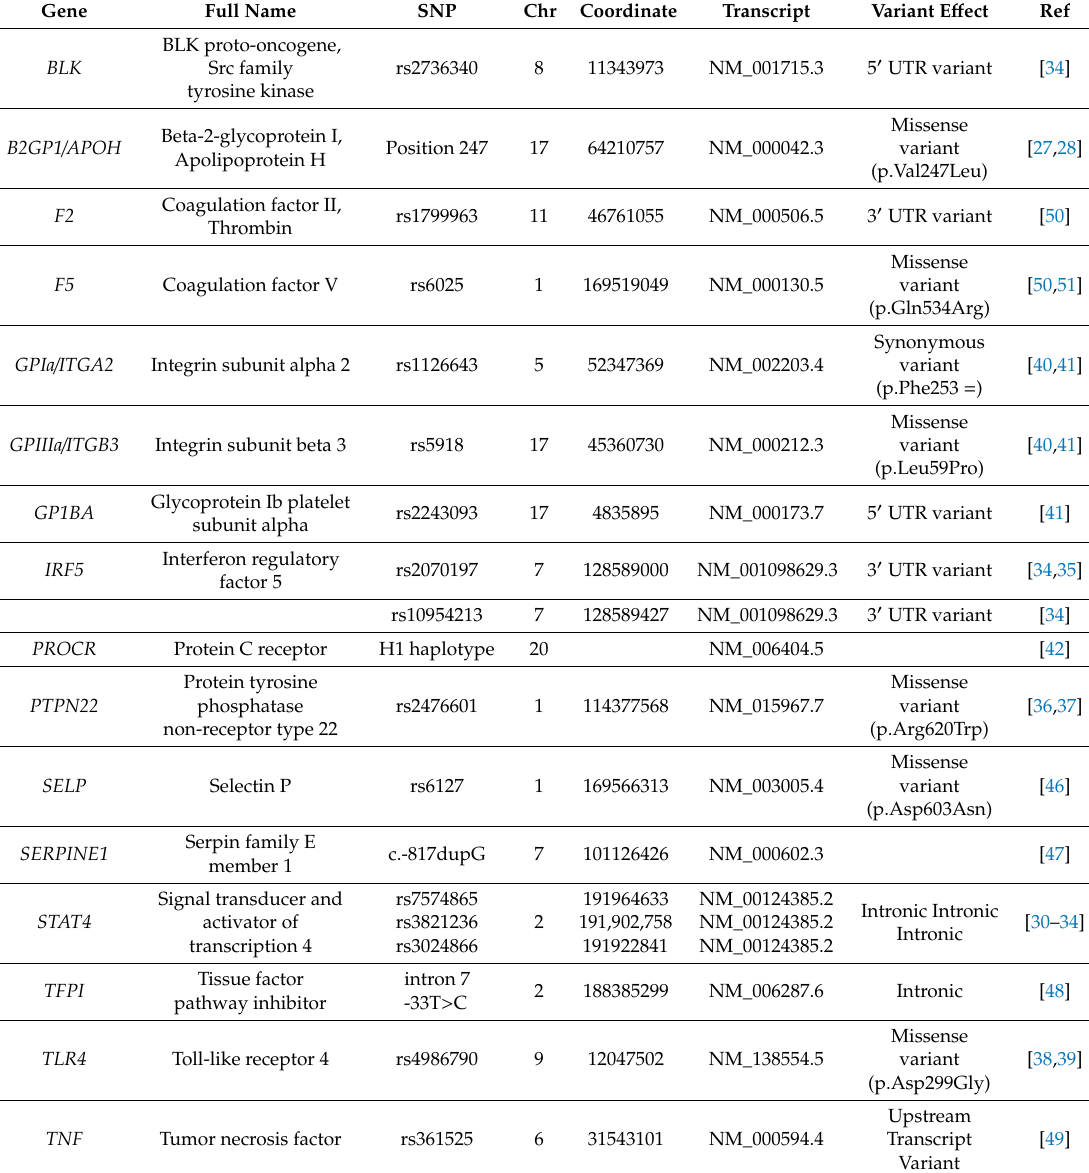
Table 1. Common mutations that have been associated with Antiphospholipid